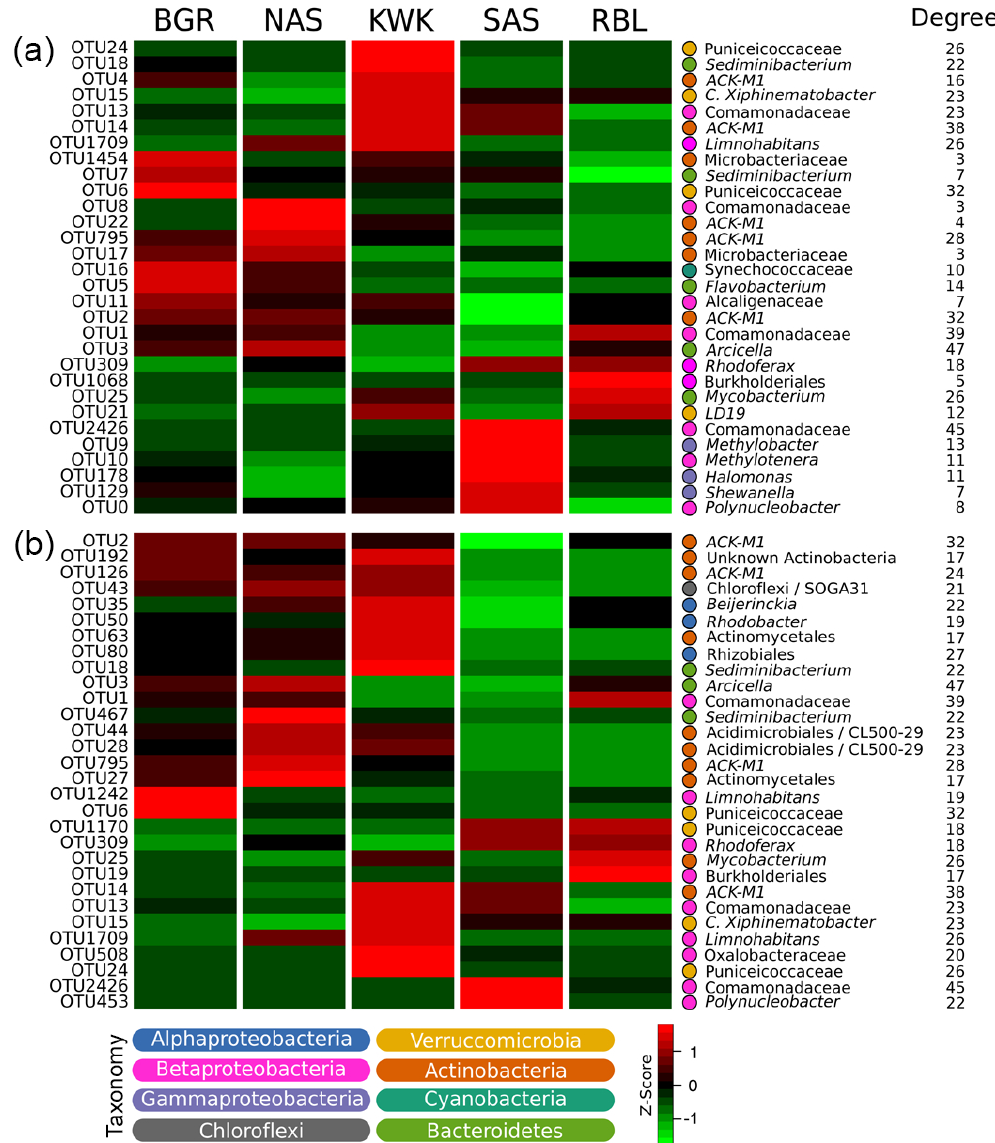
Figure 2. Heat map representation of habitat preference of the 30 most abundant (a) and most connected (b) bacterial OTUs. Habitat preference was determined by point biserial correlation. The connectivity of OTUs was defined by the degree (number of edges) of nodes from an association network (Fig. S5a). Taxonomic assignment of OTUs is provided at the lowest level of classification possible from the BLASTn search in